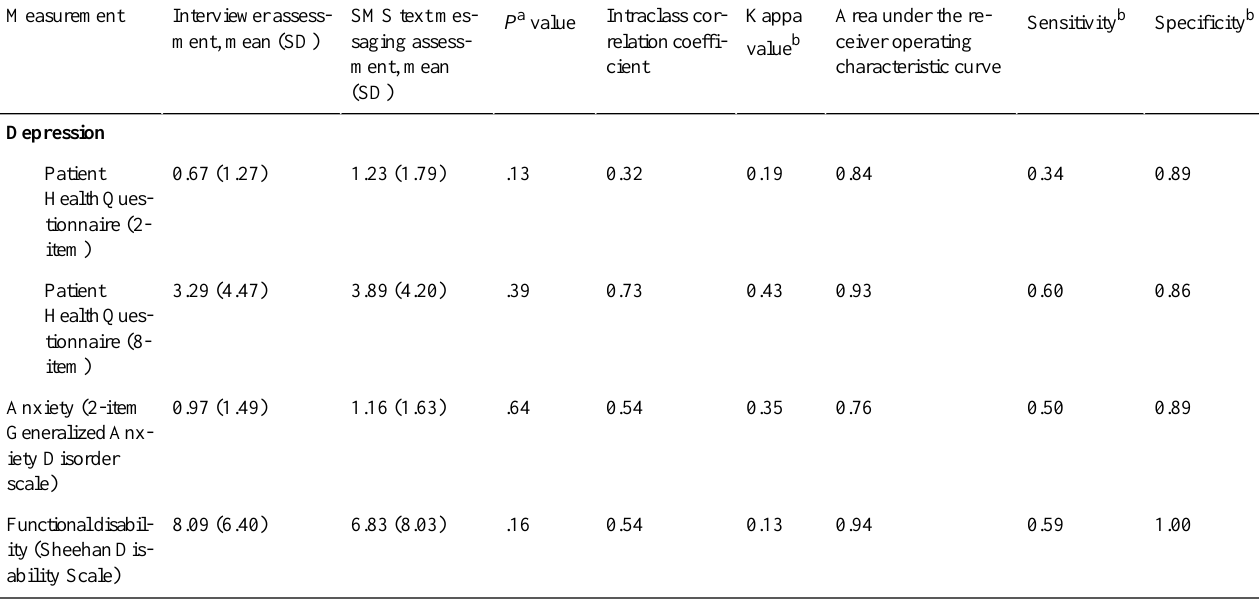
Table 3. Concordance between the interviewer and SMS text messaging